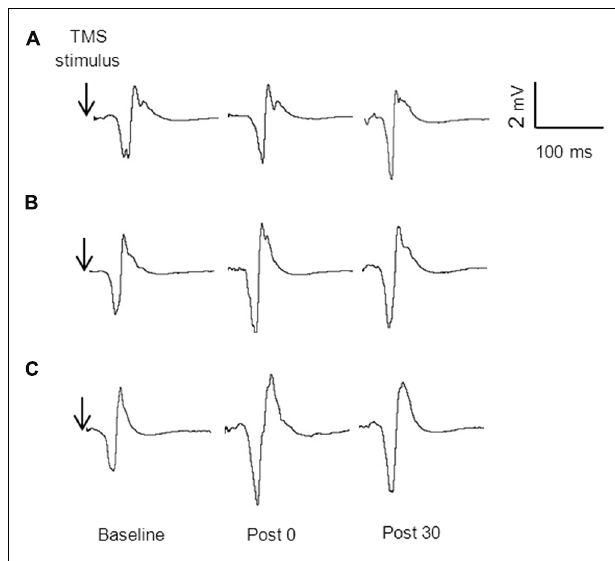
F 2.77,40.13 = 2.02, p = 0.131. Immediately following stimulation,